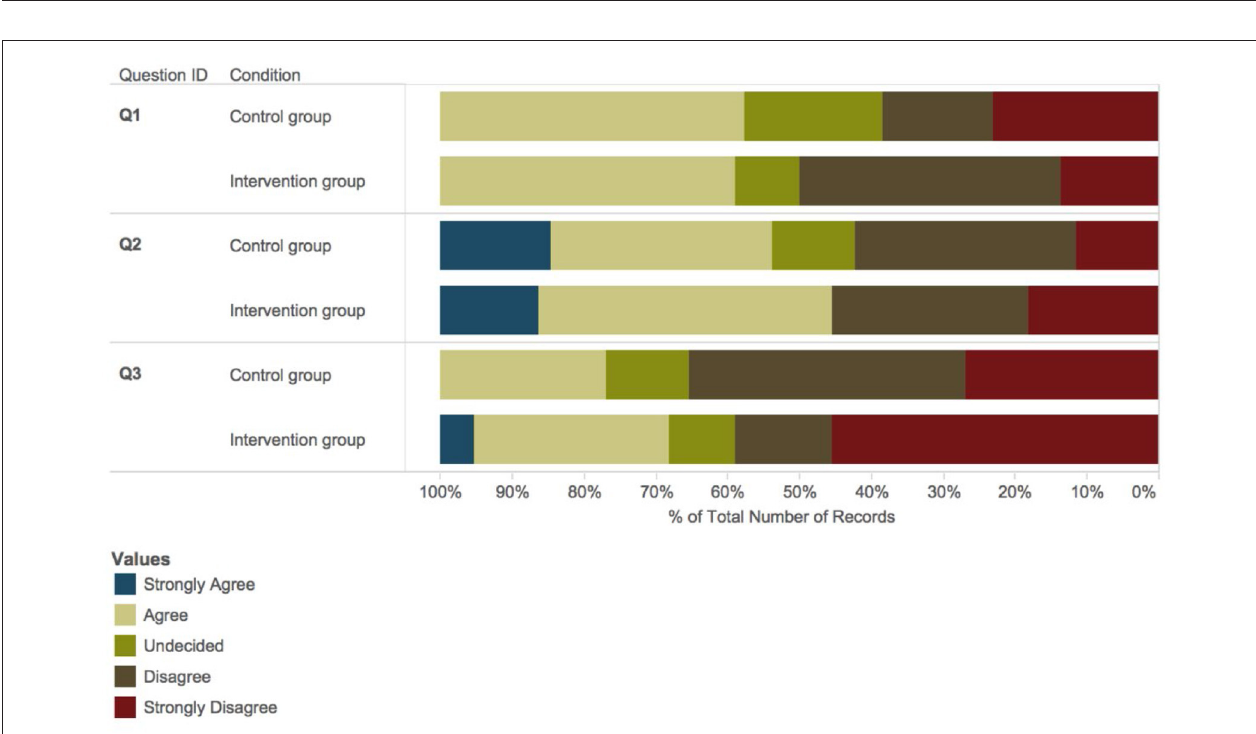
FIGURE 6 | Two examples of amounts of all six waste types based on visual inspections. Waste types are: (1) edible or once edible vegetables and fruits, (2) meat and fish, (3) grains and starches, (4) in-edibles such as peels, tea bags, bones, and egg shells, (5) compost or non-food organics such as paper towels, and (6) contamination with glass and plastics. The original waste bag is included in the picture.